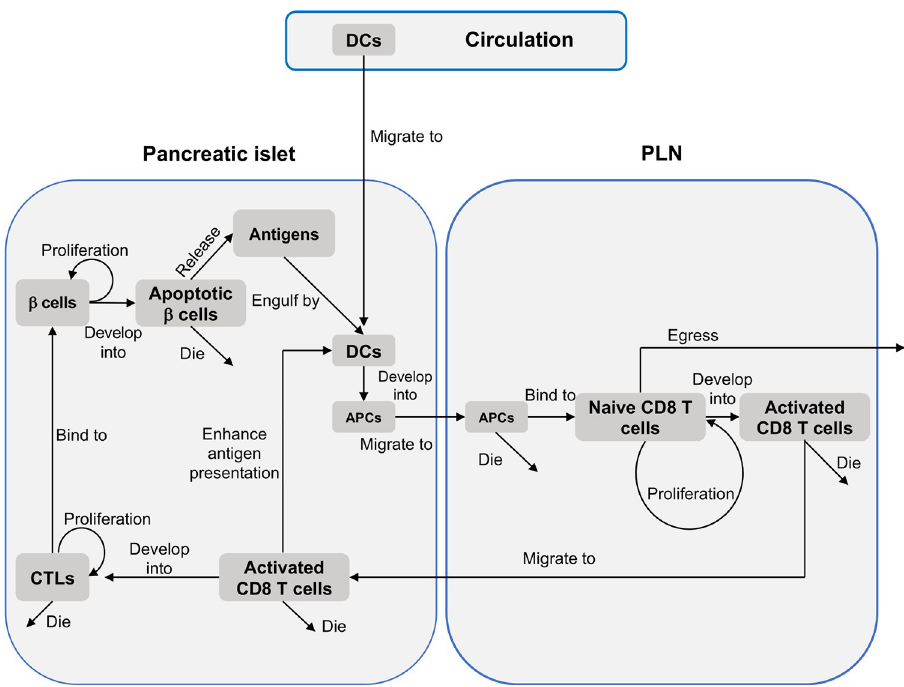
Fig 3. Components of the agent-based model. The diagram demonstrates all the interactions between agents in circulation, islets, and PLN and illustrates the level of intelligence in the ABM.